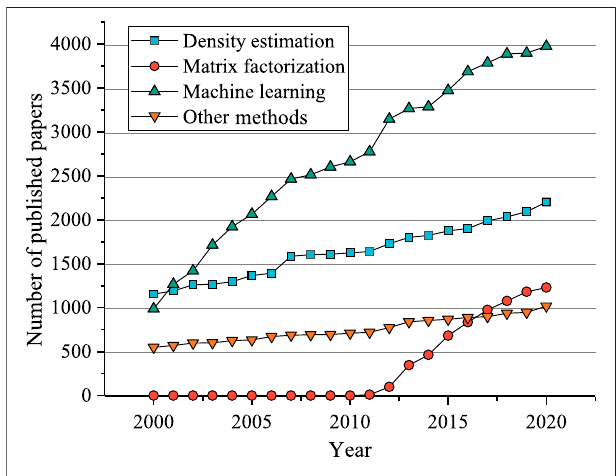
FIGURE 1 | Number of published papers about CA-based anomaly detection methods from 2000 to